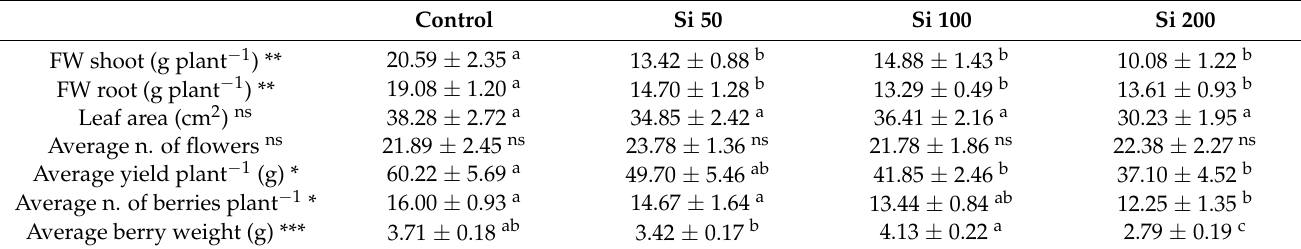
FW = fresh weight; mean ± SE; letters following the means indicate significant differences; ns = not significant; * p < 0.05, ** p < 0.01, *** p <